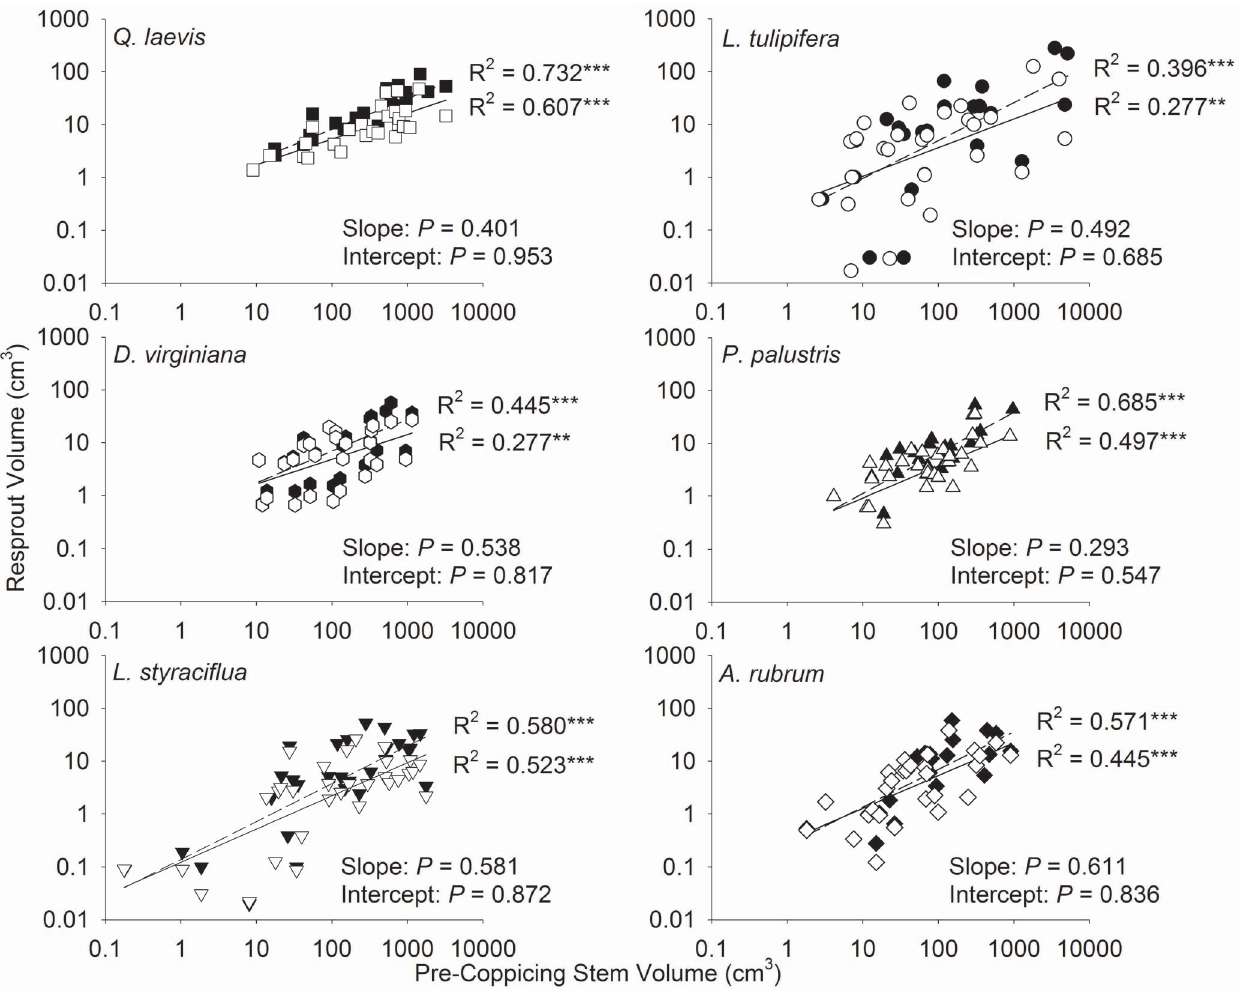
Figure 5. Relationships between pre-coppicing stem volume and resprout stem volume on a logarithmic scale. Total stem volume is denoted with filled symbols and dashed lines. Maximum stem volume is denoted with open symbols and solid lines. ** P , 0.01, *** P , 0.001 for regressions. P values for differences in slopes and intercepts between maximum and total volume are given.